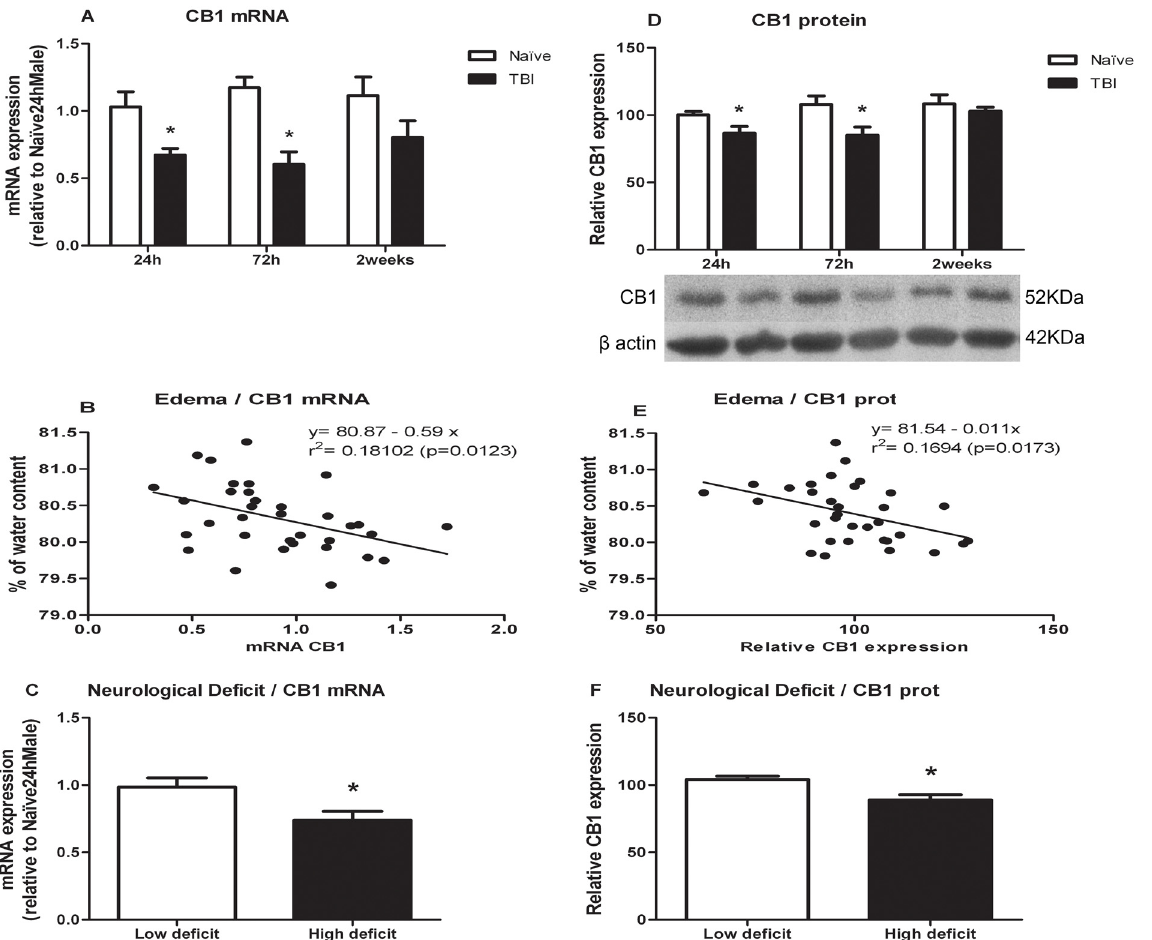
Fig 2. Effects of TBI on CB1 mRNA and protein levels. A) CB1 mRNA levels. B) Analysis of correlation between brain edema and CB1 mRNA levels. C) CB1 mRNA levels in animals classified according to neurological score. D) CB1 protein levels. E) Analysis of correlation between brain edema and CB1 protein levels. F) CB1 protein levels in animals classified according to neurological score. Data are mean ± SEM. * p < 0.05 versus na ï ve group of same time.